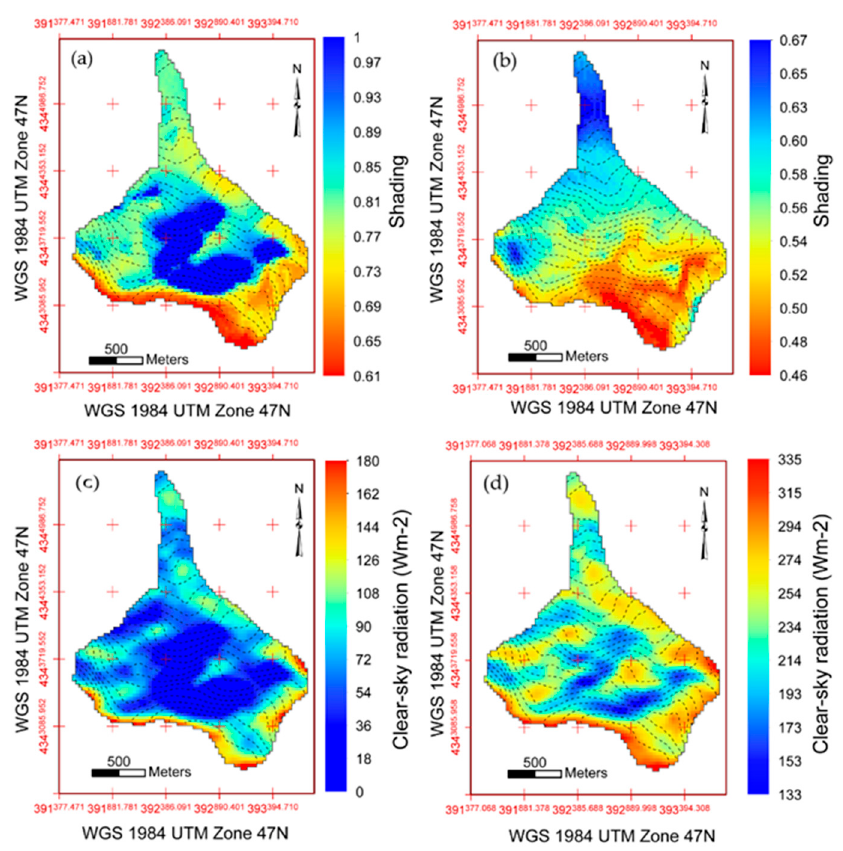
Figure 5. Spatial distribution of shading ( a , b ) and the slope corrected clear-sky potential radiation ( c , d ) in winter and summer seasons at the Qiyi glacier ( c , d ) in winter and summer seasons at the Qiyi glacier surface.